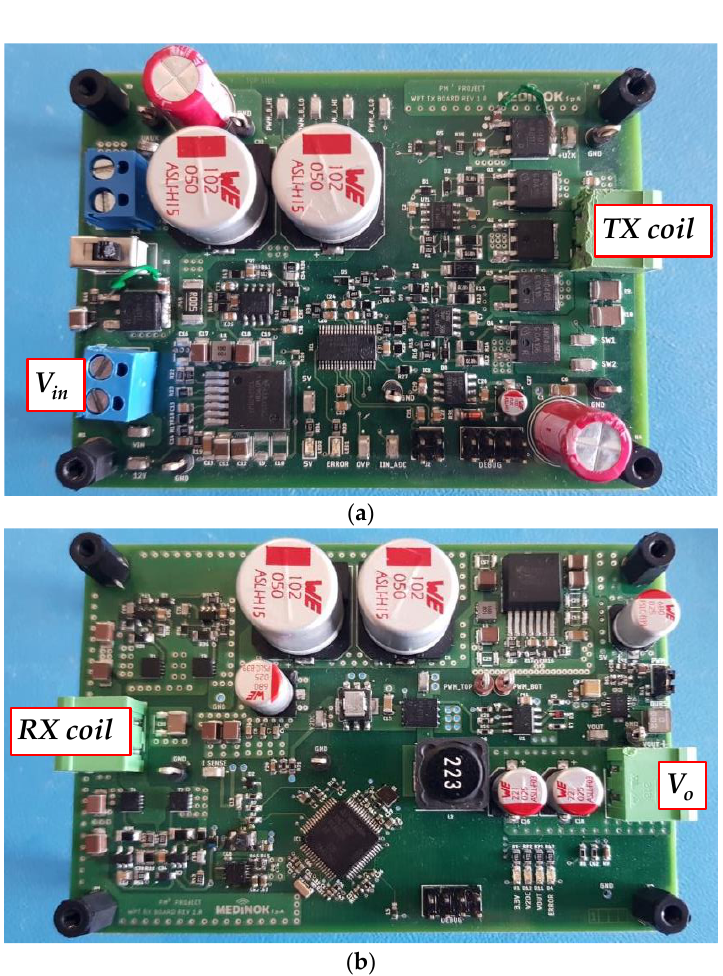
Figure 23. PCBs of the experimental prototype: ( a ) TX board; and ( b ) RX board.